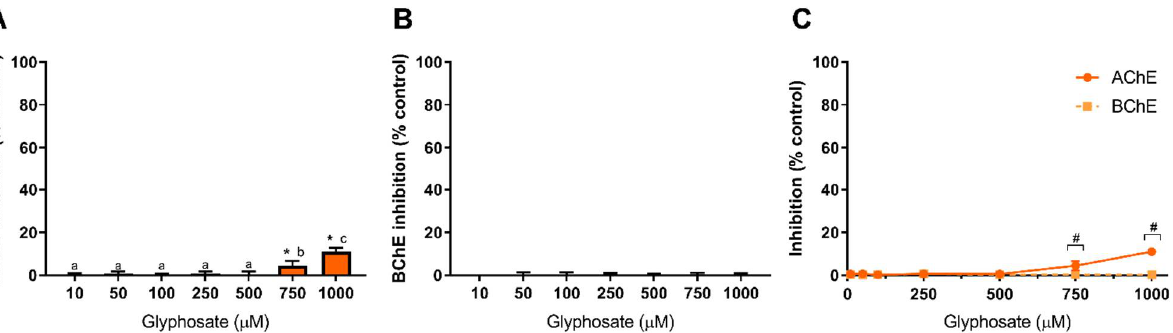
Figure 2. Glyphosate-induced inhibition of AChE ( A ), BChE ( B ) and comparison of cholinesterases affinity ( C ). Values are expressed as mean ± SD. Significant statistical differences between samples and the respective control are denoted by “*” when p < 0.05 ( A , B ), and statistical differences between enzymes at the same concentration are denoted by “#” when p < 0.05 ( C ). Different letters were used to denote significant differences between concentrations when p < 0.05 ( A ). Statistical analysis de- tails are described in methods (Section 2.3) and in Table S1.